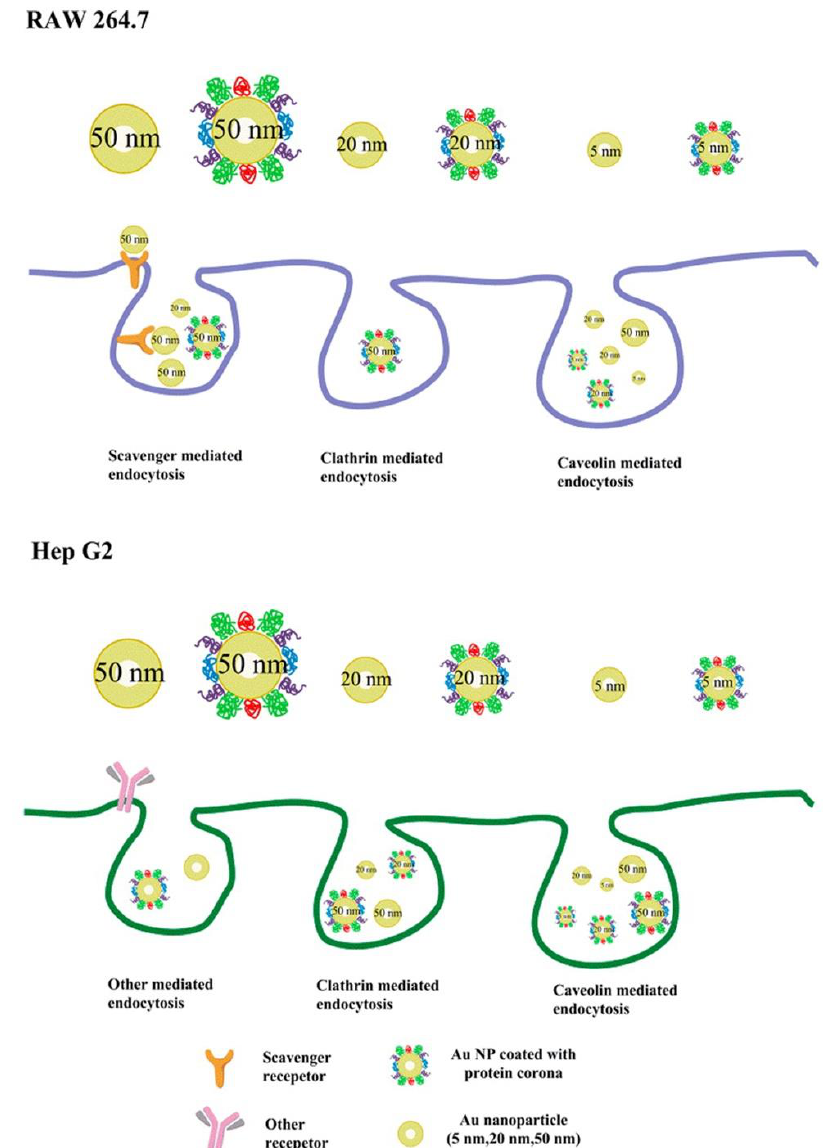
Figure 9. Proposed scheme of internalization pathways of differently sized AuNPs with or without PCs by RAW 264.7 and Hep G2 cells. Reprinted with permission from [25]. Copyright (2015) American Chemical Society.